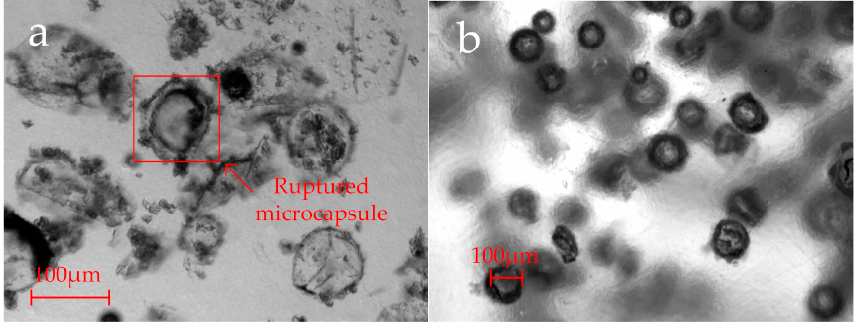
Figure 1. Microstructure of the microcapsule / LDPE (low-density polyethylene) insulating composite samples. ( a ) Original technology. ( b ) Modified technology.